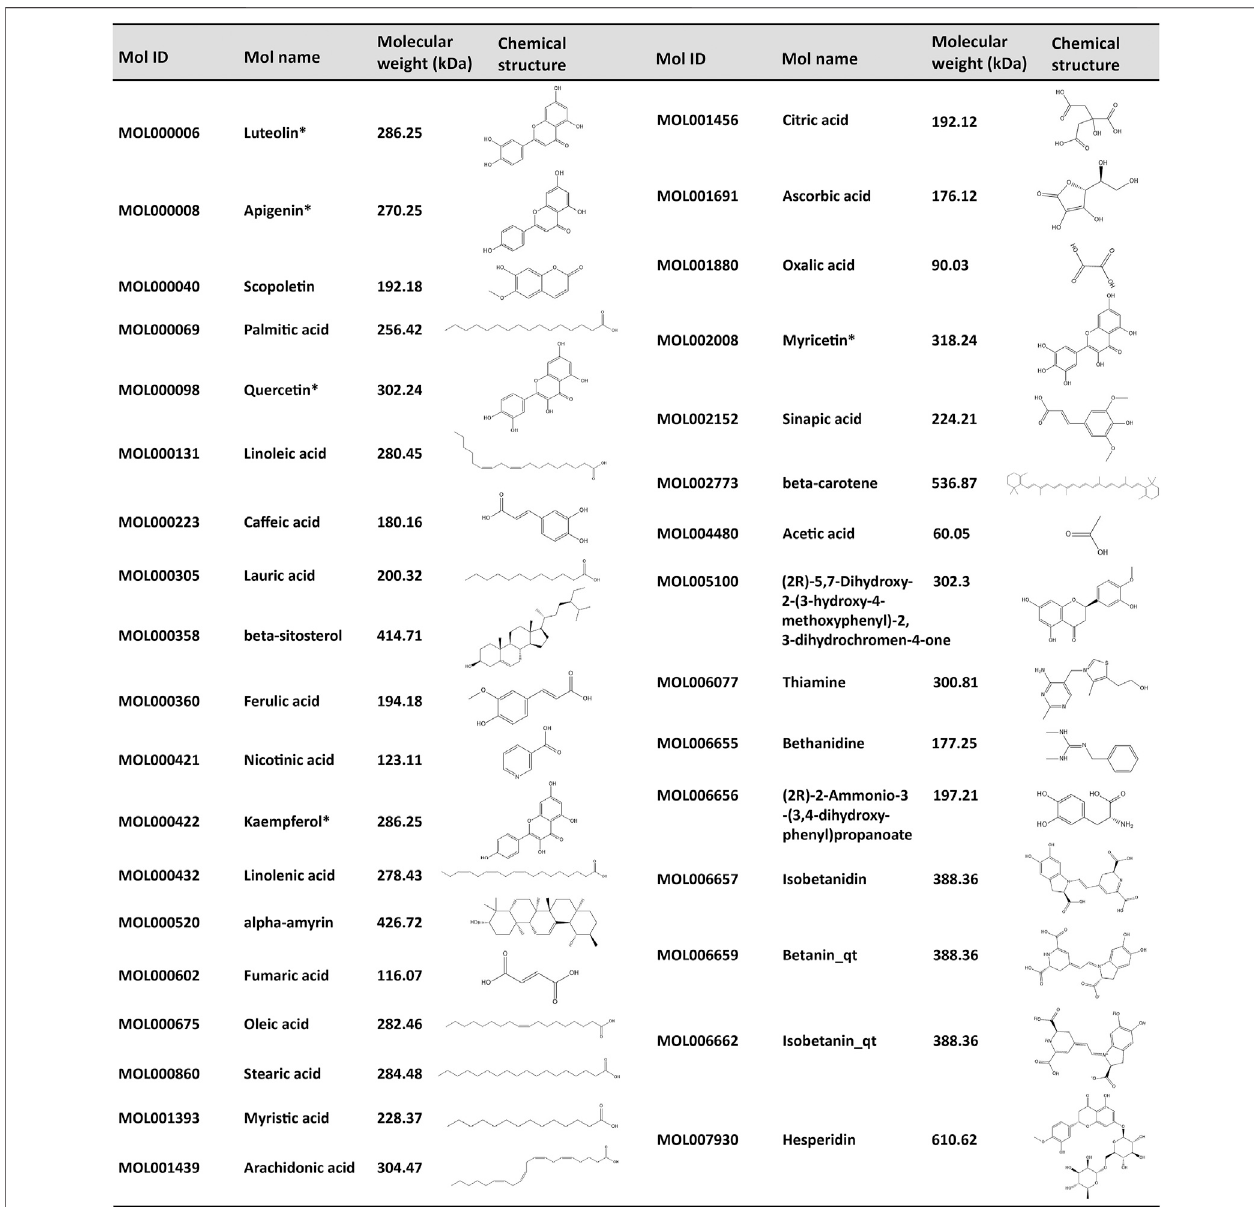
FIGURE2| CorrespondingcompoundsofN&PfromPOLinthetreatmentofNASH.ThirtyfourcorrespondingcomponentsofPOLwerecloselyrelatedtothecore genes(N&P)and obtainedfrom TCMSP database. TheMolID, Molnumber,molecular weight,and structure ofthese compounds were listed.*Potential fl avonoids from POL. “ _qt ” represented losing